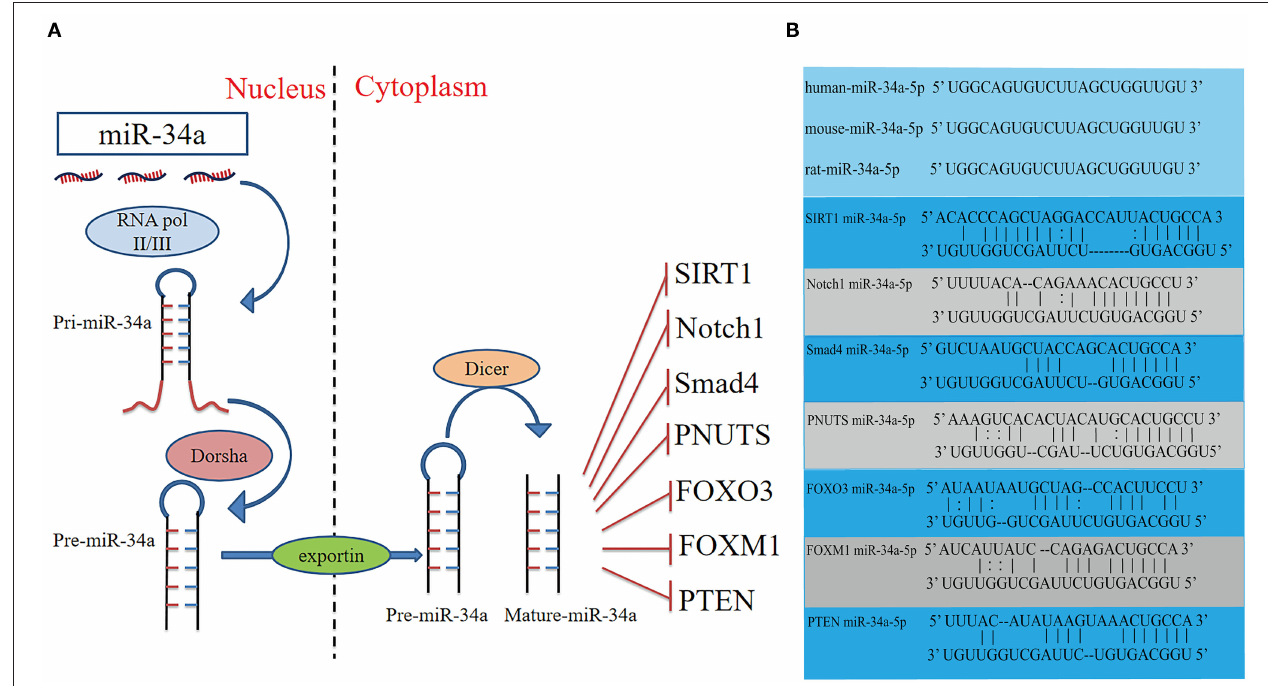
FIGURE 1 | Schematic diagram of the activities of miR-34a, and potential binding sites between miR-34a and the target genes. (A) Schematic diagram of the activities, and target genes of miR-34a. (B) The sequence of miR-34a-5p is conserved in humans, mice and rats. The potential miR-34a-5p-binding sites of target genes. FOXM1, Forkhead box M1; FOXO3, Fork head box O3; PTEN, Phosphatase and tensin homologue; SIRT1, Silent information regulator